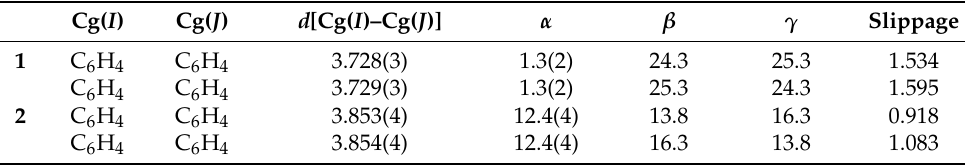
Table 3. π · · · π Distances (Å) and Angles ( ◦ ) for 1 and 2 1 . Table 3. π ⋯ π Distances (Å) and Angles (°) for 1 and 2 . 1